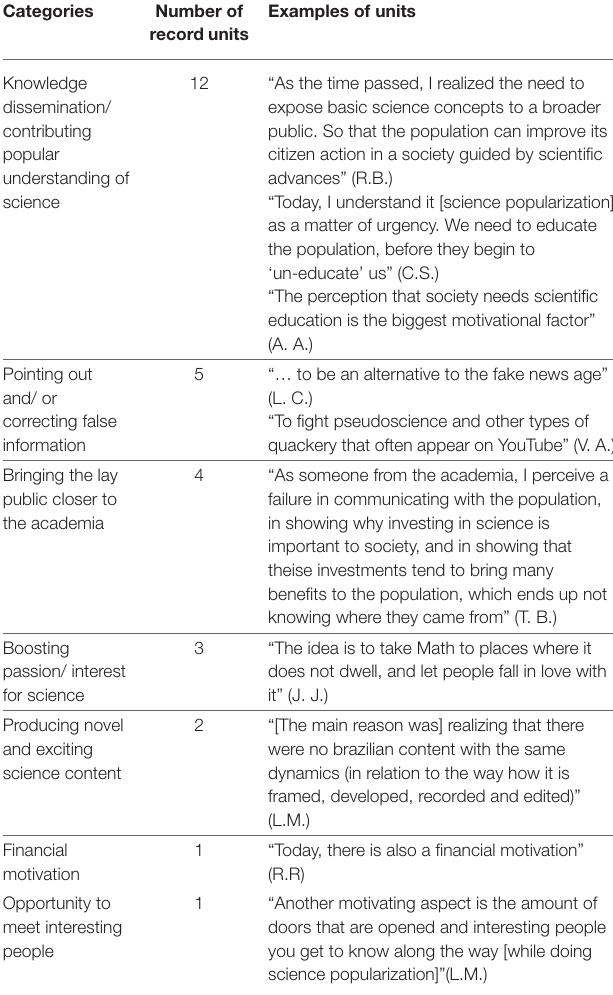
TABLE 1 | Motivations to communicate science on